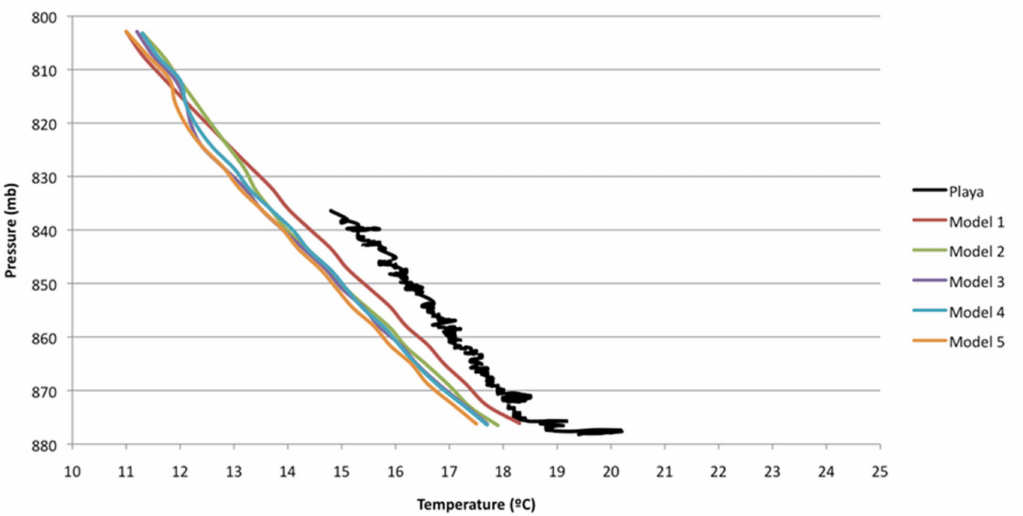
Figure 18. Model upper-air temperature profile ( ◦ C) shown by pressure level (hPa) for different model experiments vs. tethersonde at 2200 UTC 10-14-2012 at the Playa